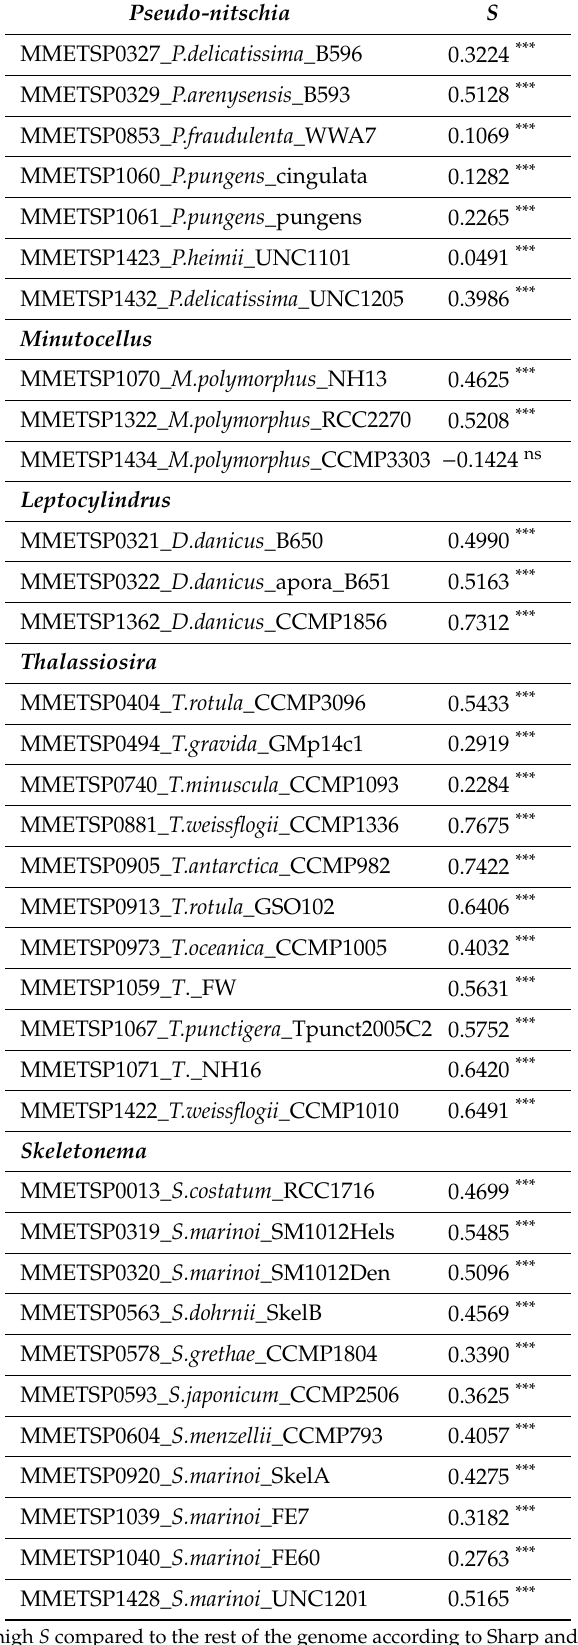
Table 1. Strength of selection only calculated with codons that did not show any change in preferred codon usage within a